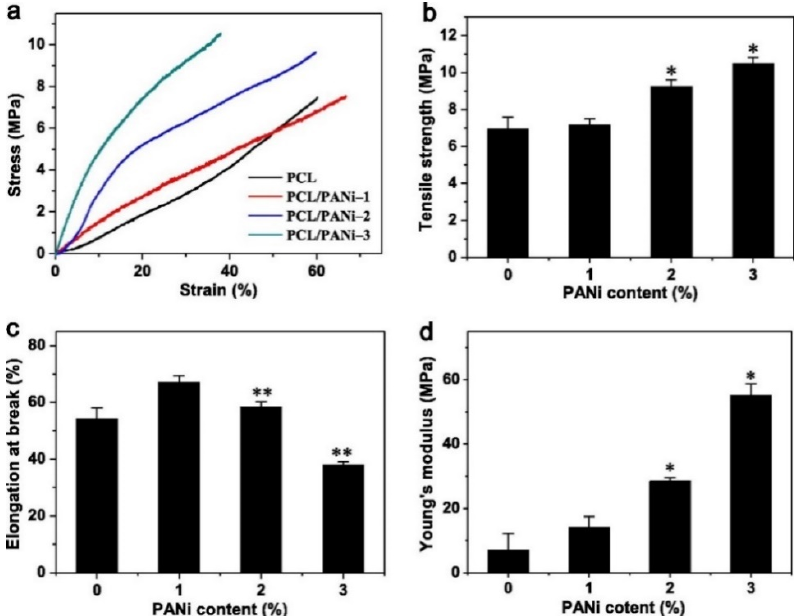
Figure 3. Effect of incorporating PANI into PCL nanofibrous scaffold to its mechanical properties. ( a ) Stress-strain curve, ( b ) Tensile strength, ( c ) Elongation at break, and ( d ) Young’s modulus. *Significantly different from pure PCL ( p < 0.05, n = 5); **Significantly different from PCL-PANI-1 ( p < 0.05, n = 5). Reproduced with permission from [51]. Copyright (2013) Elsevier.